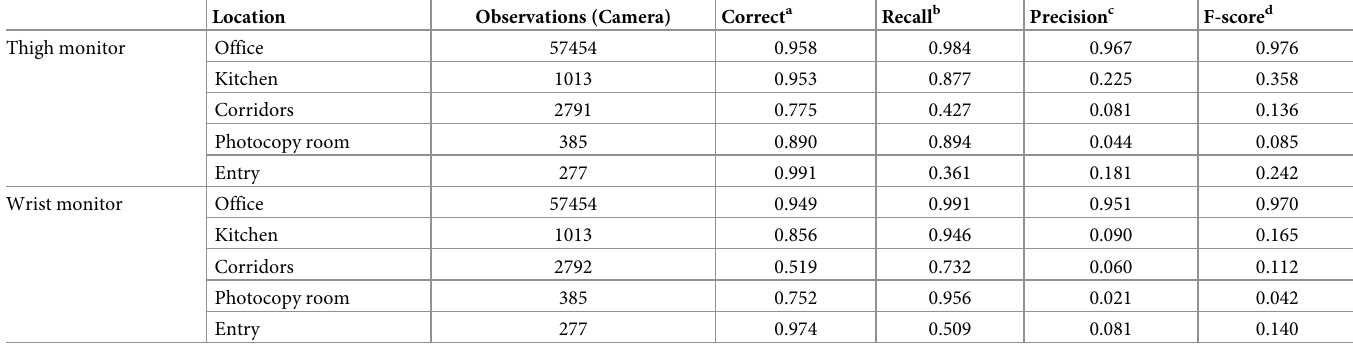
Table 2. Agreement with direct observation of the monitor-ascertained presence/absence at each location, using beacons from one location at a time (n = 30 partici- pants, n = 67616 observations).